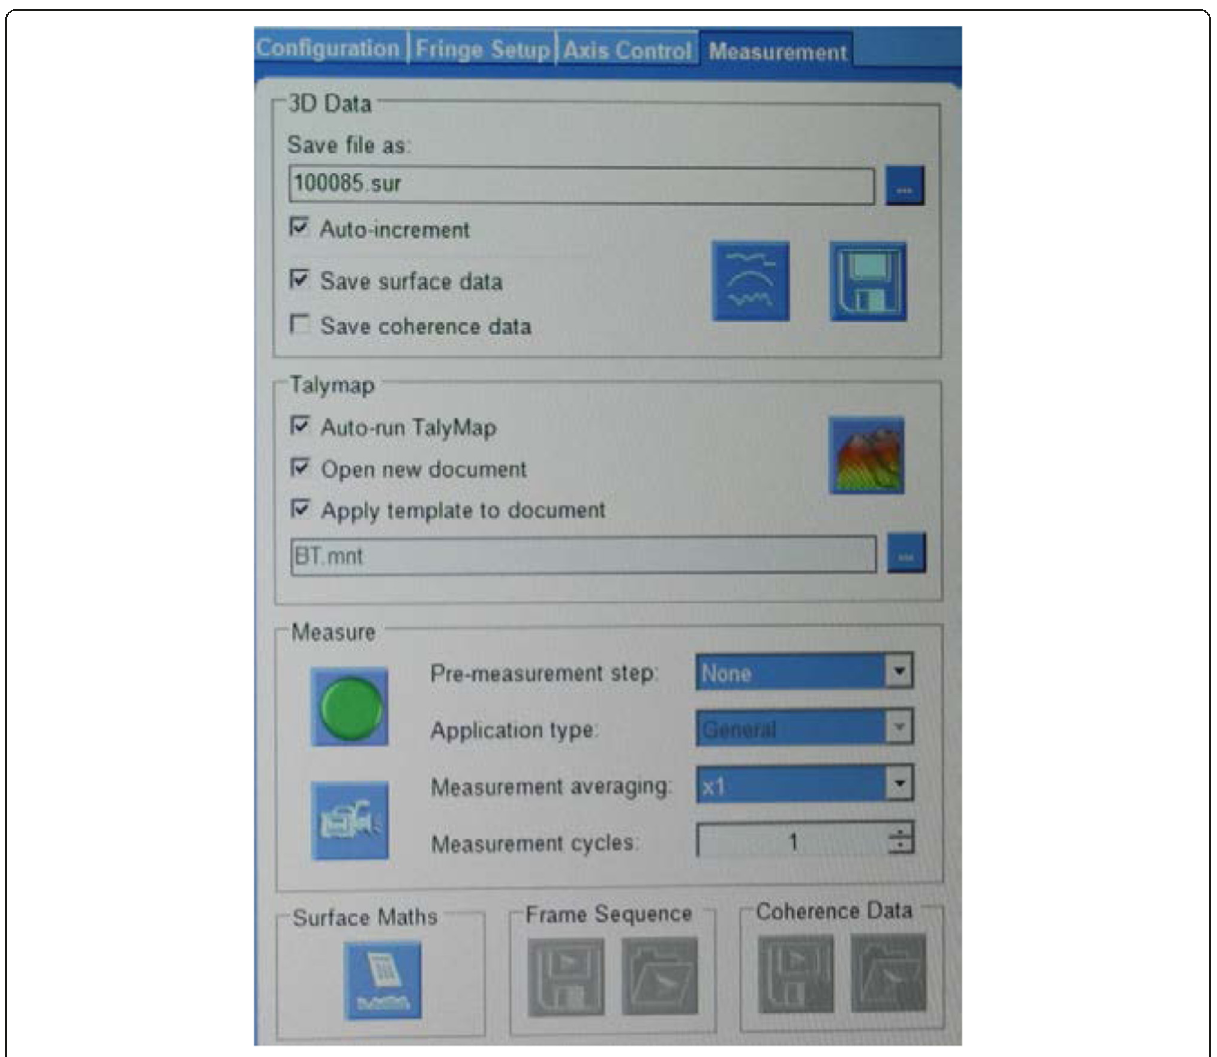
optical surface profilometer machine. The surface roughness was highest for group A, followed by C, B and D, respectively. Groups B and D provided smooth surface roughness; however, group D had the very smooth surface with values 0.74 and 0.75 for the me- sial and distal slots, respectively. In order to select the proper low-friction bracket system, clinicians should consider specific character- istics of slot design [30]. MBT recommends 0.022- in.-slot height than 0.018-in.-slot height [31]. Re- garding the use of 0.022-in.-slot, 54 % of orthodon- tists preferred the 0.022-in.-slot size [32]. With this view, we decided to take 0.022-in. MBT slot conven- tional stainless steel brackets for the present study. Upper-right first premolar brackets were included in this study as to maintain a standardized